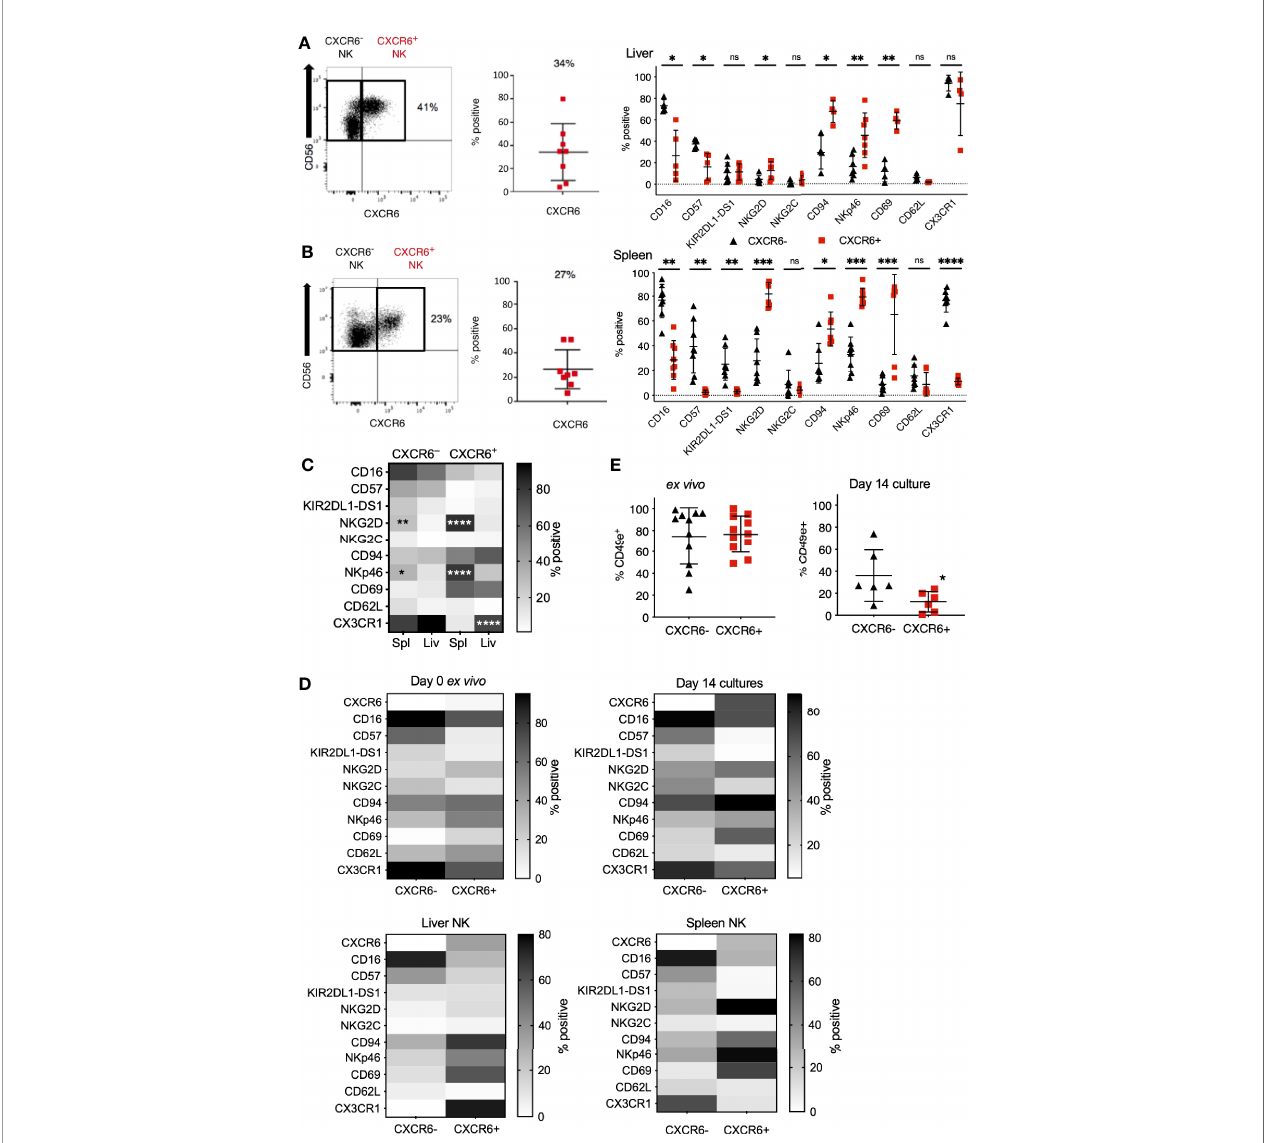
FIGURE 3 | Phenotypic differences between CXCR6 - and CXCR6 + NK cells are augmented in the spleen compared to liver and PB-NK cells. CXCR6 - (black triangles) and CXCR6 + (red squares) liver and spleen NK cells were interrogated for various NK cell markers by fl ow cytometry. (A) CXCR6 + liver NK cells have a less mature, more tissue-resident phenotype than CXCR6 - liver NK ( n=5-7 ). (B) Phenotypic differences between CXCR6- and + NK cell subsets are augmented in the spleen ( n=8 ) (paired t-test for each marker). (C) Direct comparison of CXCR6 - spleen to CXCR6 - liver NK cells; and CXCR6 + spleen to CXCR6 + liver NK cells (two-way ANOVA with Sidak ’ s multiple comparison ’ s test). (D) Heat map summary comparing NK cell markers in CXCR6 - and CXCR6 + NK cells in ex vivo peripheral blood, 14-day cultures, liver, and spleen. Increasing intensity is equivalent to higher expression. Corresponding p values can be found in Figures 1D, E , 3A, B . (E) CD49e is decreased on CXCR6 + NK cells compared to CXCR6 - NK after 14 days in culture. For ex vivo NK cells, n=11 ; for 14-day cultured NK cells, n=6 (paired t-test). P values are as denoted in the legend to Figure 1 . *p < 0.05; **p < 0.01; ***p < 0.001; ****p < 0.0001; ns, not signi fi